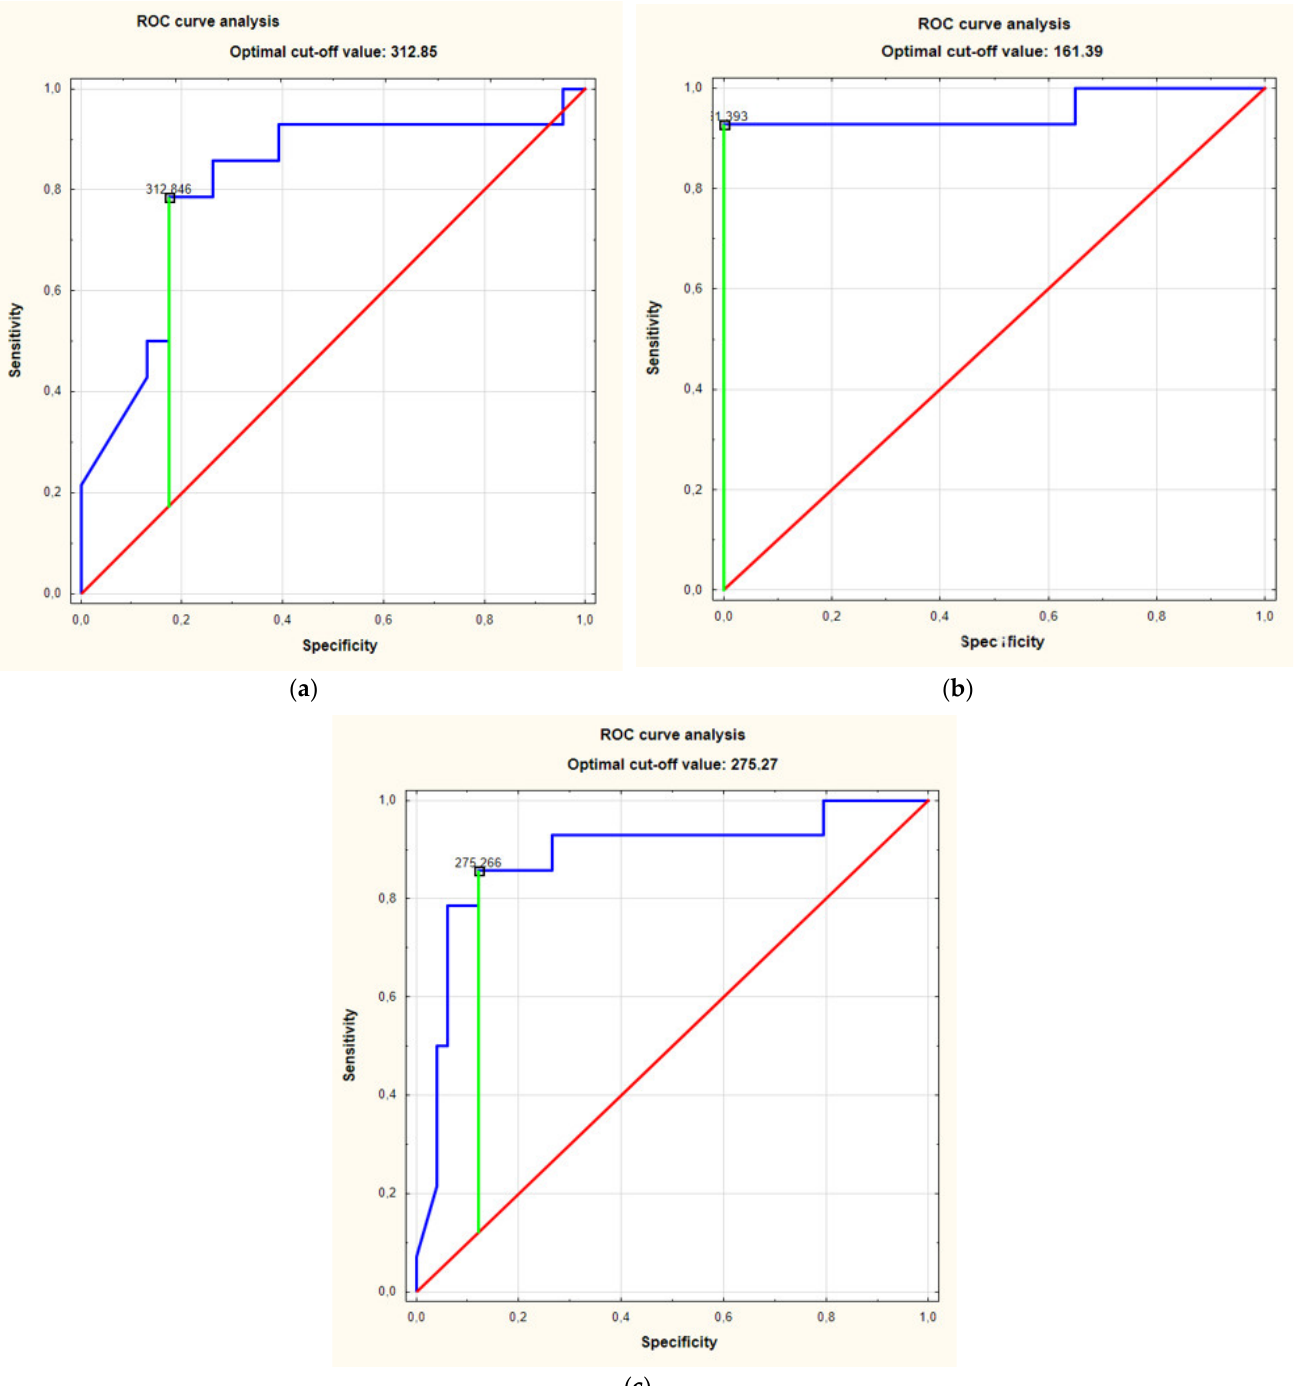
Figure 3. ( a ). There was no significant difference in serum concentrations of S100A15 between patients suffering from HS and controls ( p > 0.05). ( b ). There was statistically significant difference in S100A15 serum concentrations between Hurley stages ( p < 0.0001). The serum concentrations of S100A15 in patients in Hurley III stage were significantly elevated as compared to controls, individuals with HS in Hurley I stage and individuals with HS in Hurley II stage ( p = 0.0013, p < 0.0001 and p = 0.0004 respectively). * is statistically significant result p < 0.05. The ROC curve analysis showed an AUC of 0.81 (95%CI for AUC: 0.66–0.97) ( p =